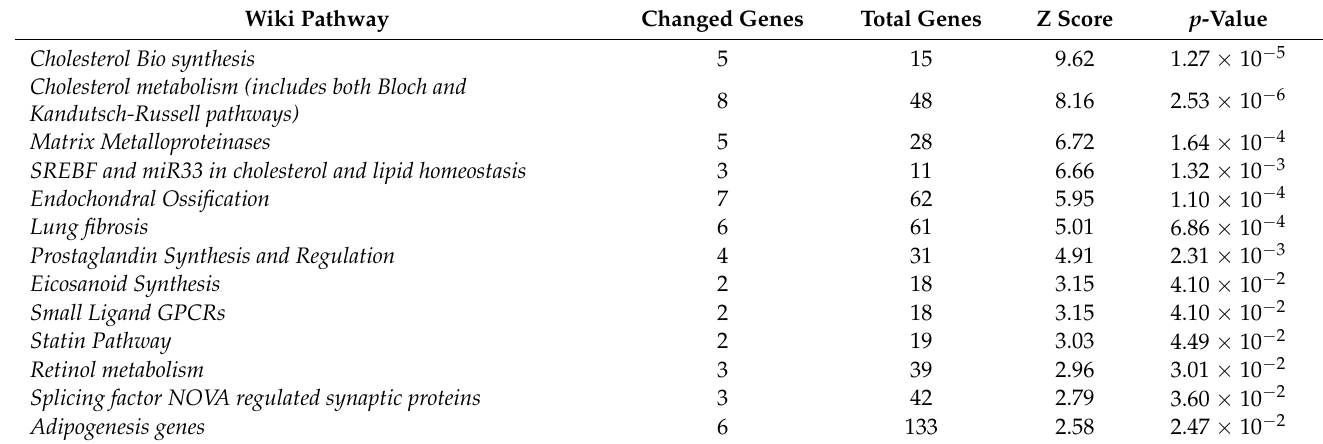
Table 2. Pathway enrichment analysis in two mouse models of prostate cancer fed with a lard diet and fish oil